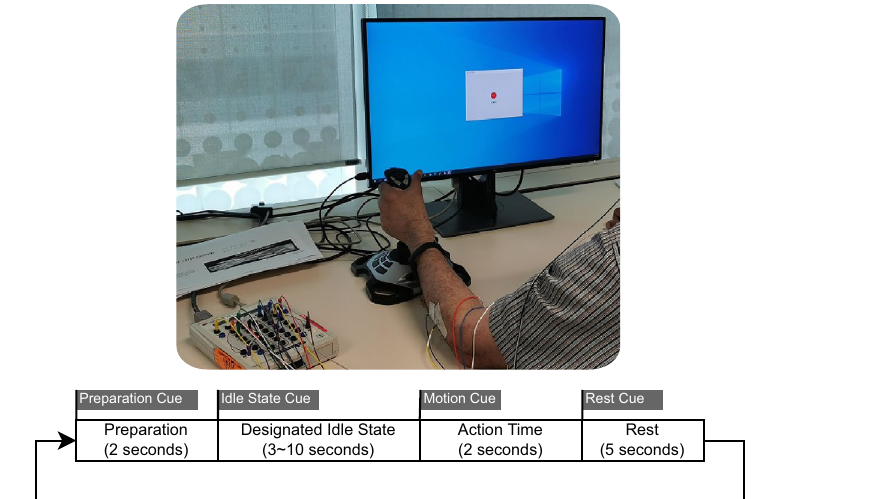
Figure 1. The data collection system and the time structure of a motion task